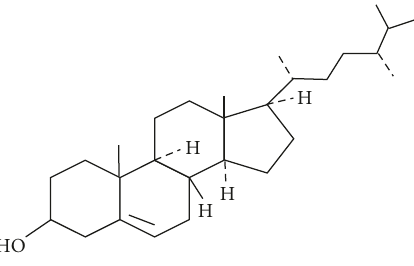
Figure 11: Chemical structure of